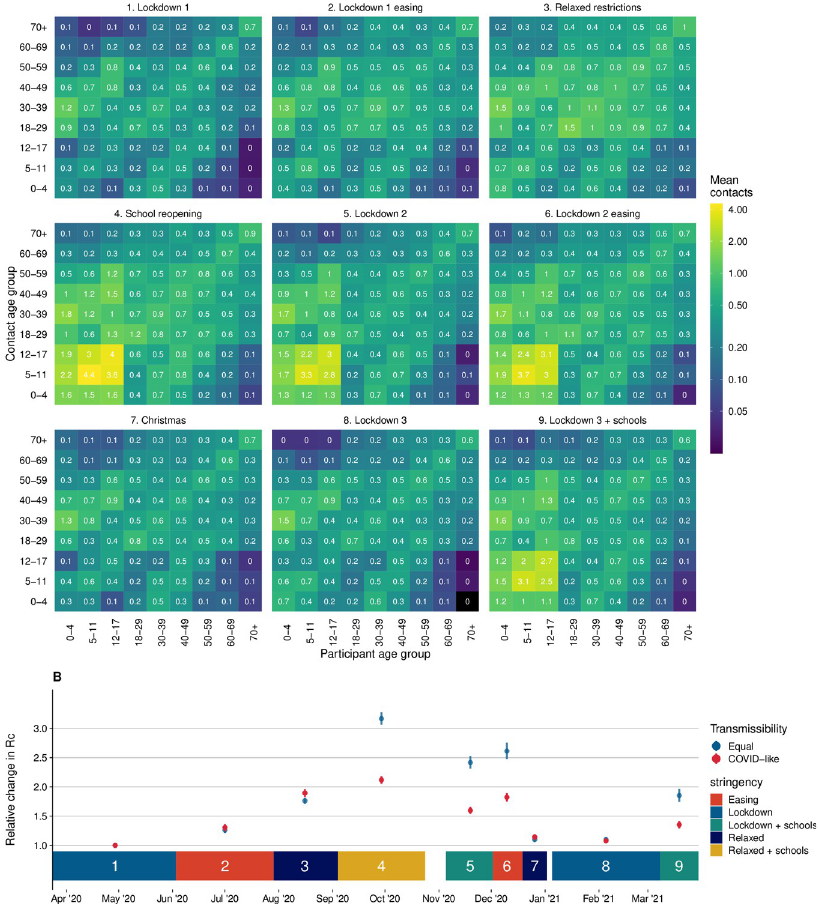
Fig 6. Contact matrices and their dominant eigenvalues for England in each period considered. (A) Contact matrices for England across the 9 periods (1. Lockdown 1, 2. Lockdown 1 easing, 3. Relaxed restrictions, 4. School reopening, 5. Lockdown 2, 6. Lockdown 2 easing, 7. Christmas, 8. Lockdown 3, and 9. Lockdown 3 + schools). (B) Points show relative change in R_0 (compared to Lockdown 1) based on the dominant eigenvalues of effective contact matrices calculated for periods 1 to 9, with equal transmissibility in all age groups and age-stratified transmissibility based on Davies and colleagues for SARS-CoV-2. Coloured blocks show durations of each period as annotated. COVID, Coronavirus Disease; R c , basic reproduction number under controlled conditions; SARS-CoV-2, Severe Acute Respiratory Syndrome Coronavirus